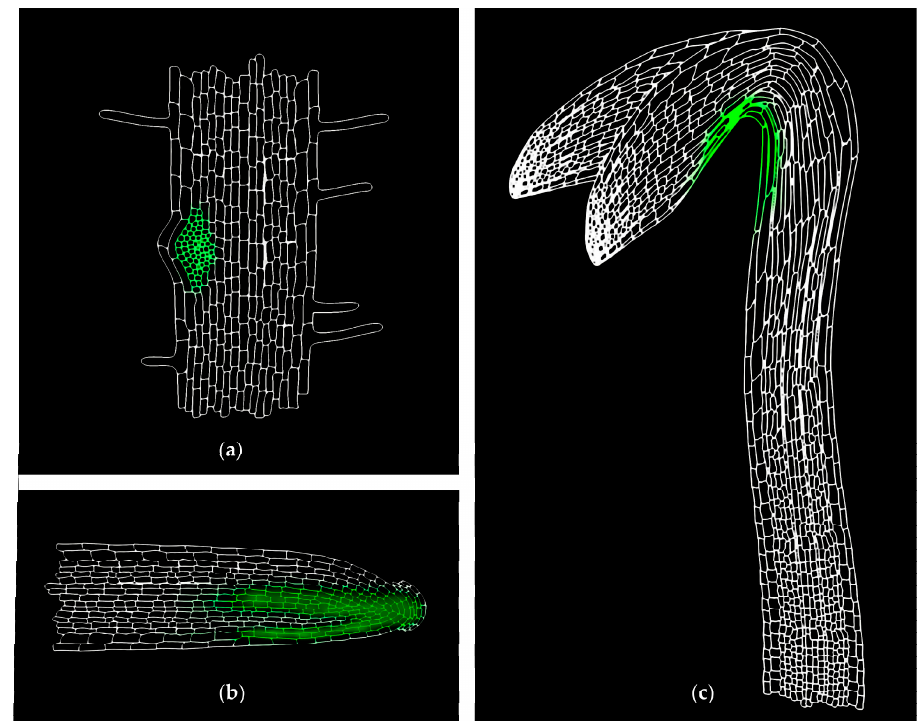
Figure 3. Scheme of tissue-specific localization of fluorescent auxin analogues. The active auxin transport carriers regulate the asymmetric distribution of auxins within different developmental processes. The distribution pattern of fluorescently labelled auxins should mimic the native IAA gradients in specific tissues such as ( a ) lateral root initiation sites, ( b ) the lower side of gravistimulated roots, or ( c ) the concave side of apical hook. Moreover, the non-specific fluorescent signal needs to be investigated, for instance by using a fluorescent analogue non-specific for polar auxin transport machinery. Green color represents localization of auxin analogue labeled with green fluorophore, e.g., NBD (7-nitro-2,1,3-benzoxadiazole).